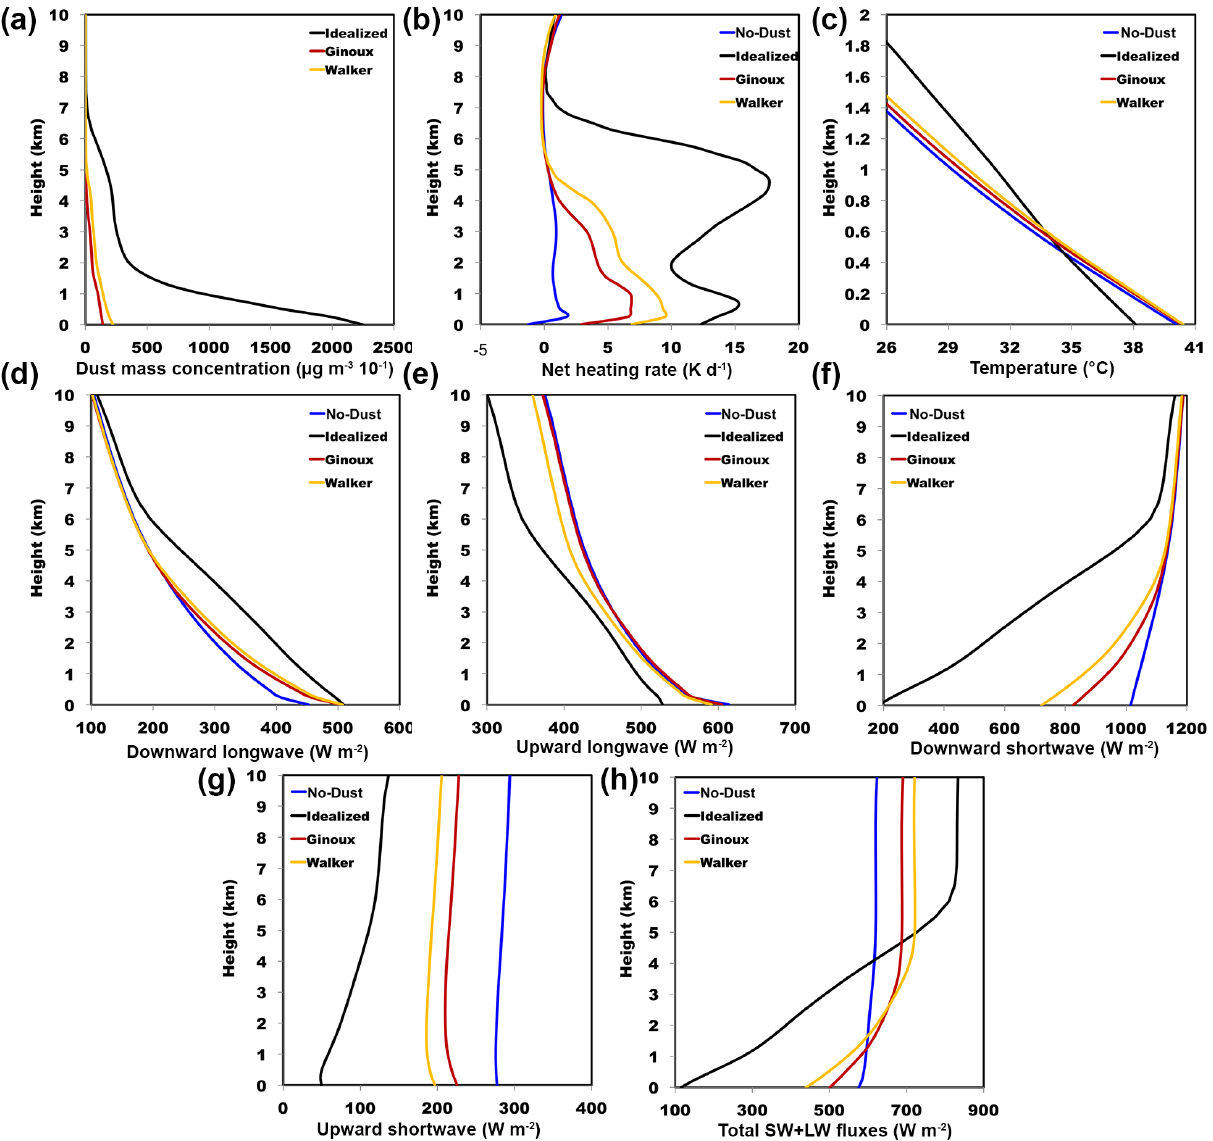
Figure 9. Daytime 10:00UTC ( ∼ 14:00LST) vertical profiles on 4 August of analysis-area-averaged (a) dust mass concentration (µgm − 3 × 10 − 1 ), (b) net radiative heating rate (Kd − 1 ) , (c) temperature ( ◦ C), (d) downward longwave (Wm − 2 ) , (e) upward longwave (Wm − 2 ) , (f) downward shortwave (Wm − 2 ), (g) upward shortwave (Wm − 2 ) , and (h) total radiative fluxes (Wm − 2 ) computed as the sum of shortwave and longwave and downward minus upward fluxes. Note that panel (c) is on a different vertical scale so as to zoom in on lower-level